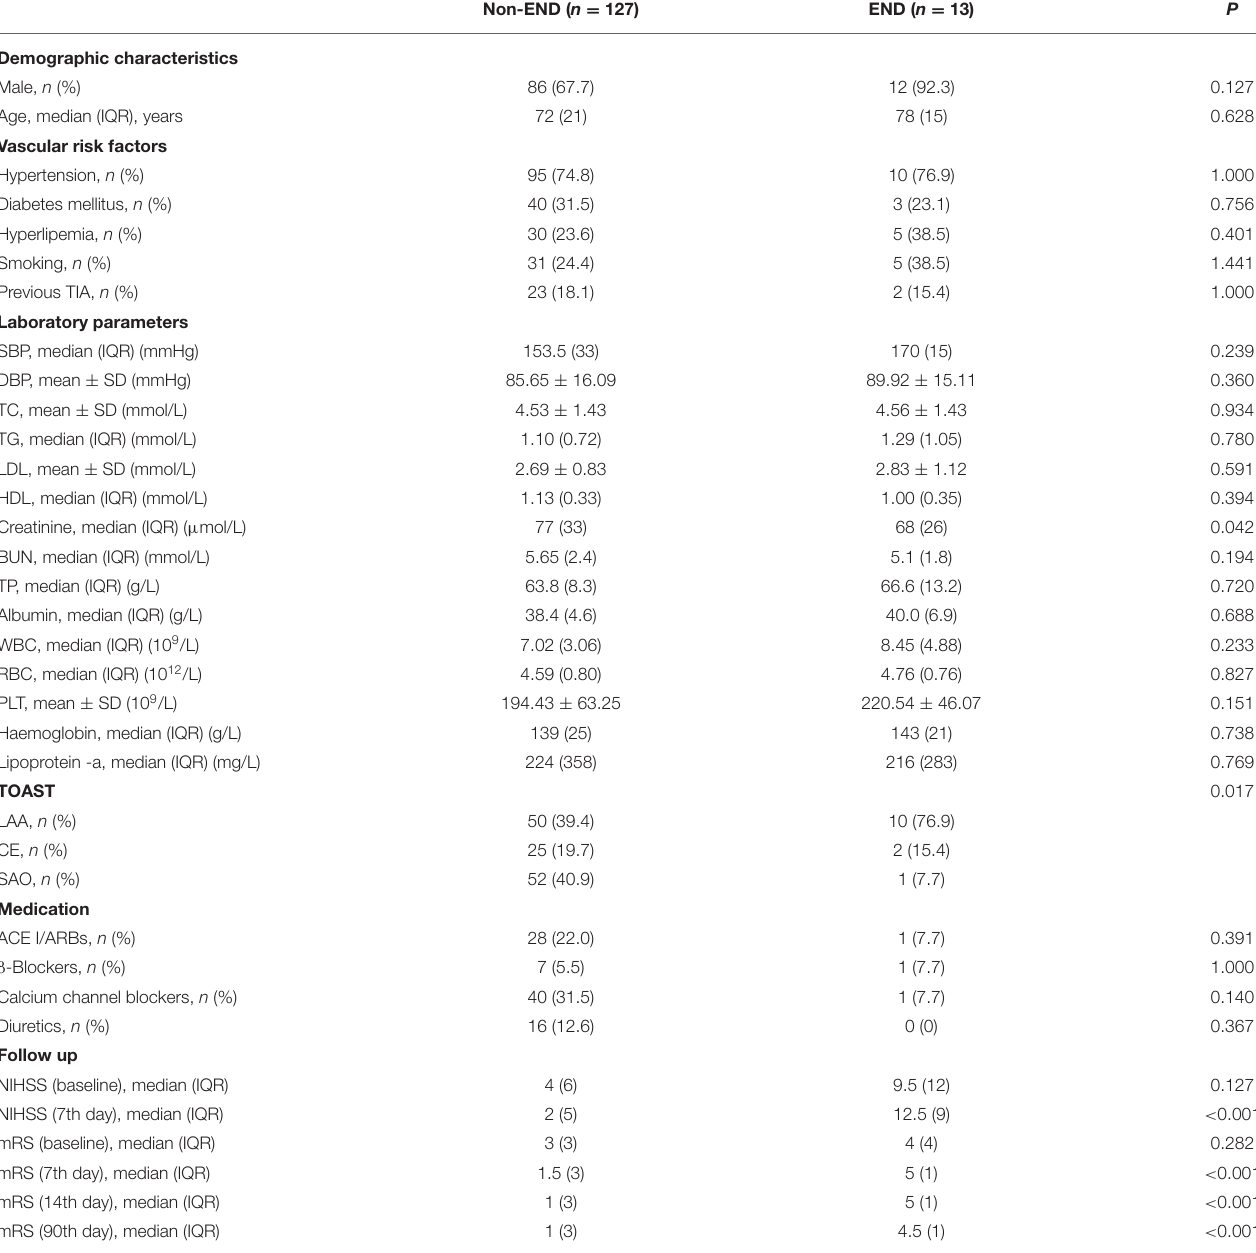
TABLE 1 | The general characteristics of stroke patients with END and